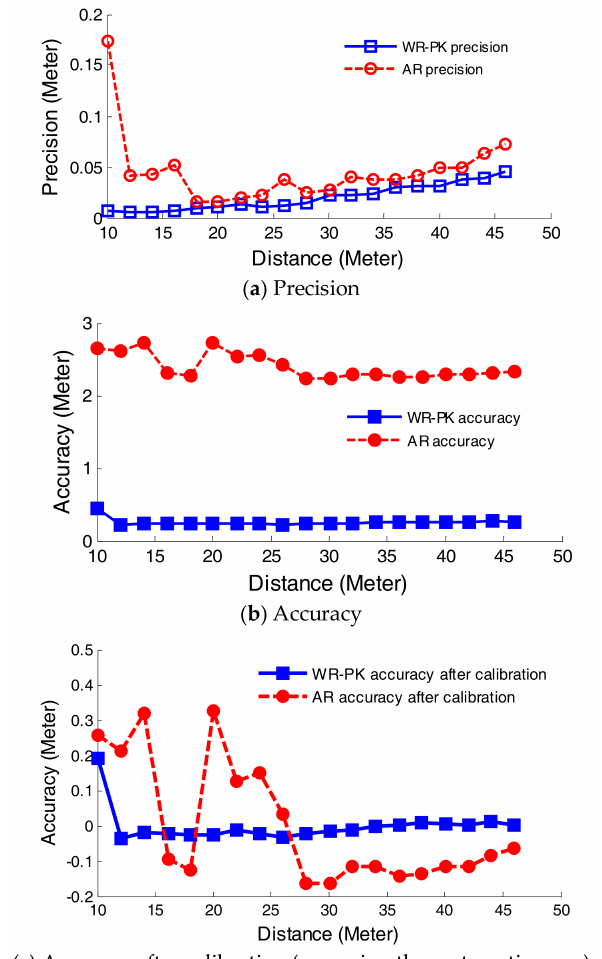
Figure 10. Ranging performances comparison between analog discrete return system (AR) and waveform-digitizing system